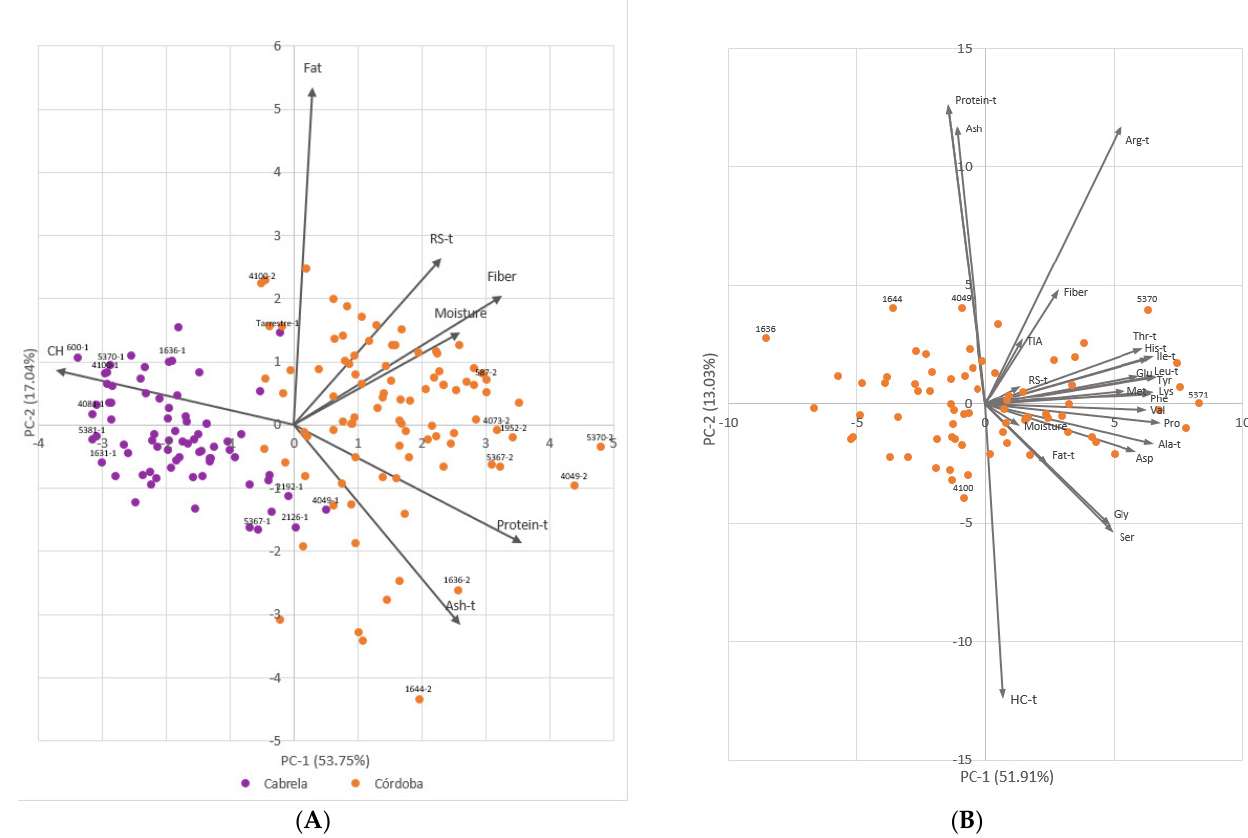
Figure 2. Principal component analysis based on BLUEs of nutritional composition and protein quality-related traits measured in a collection of 106 Portuguese common bean accessions. ( A ) Biplot representing accessions grown in Cabrela (purple) and accessions grown in Córdoba (orange). Trait loading vectors of the seven nutritional composition-related traits are represented by arrows. Relevant accessions are identified by their accession numbers followed by 1 or 2 according to the corresponding environment: 1-Cabrela; 2-Córdoba. ( B ) Biplot representing accessions grown in Córdoba (orange). Trait loading vectors of the 24 nutritional composition and protein quality-related traits are represented by arrows. CH- carbohydrates; RS-resistant starch; Ala-alanine; Arg-arginine; Asp-aspartic acid; Glu-glutamic acid; Gly-glycine; His- histidine; Ile-isoleucine; Leu-leucine; Lys-lysine; Met-methionine; Phe-phenylalanine; Pro-proline; Ser-serine; Thr- threonine; Tyr-tyrosine; Val-valine; TIA-trypsin inhibitor activity. The “-t” after the trait’s name indicates that data was transformed following a Box-Cox transformation.